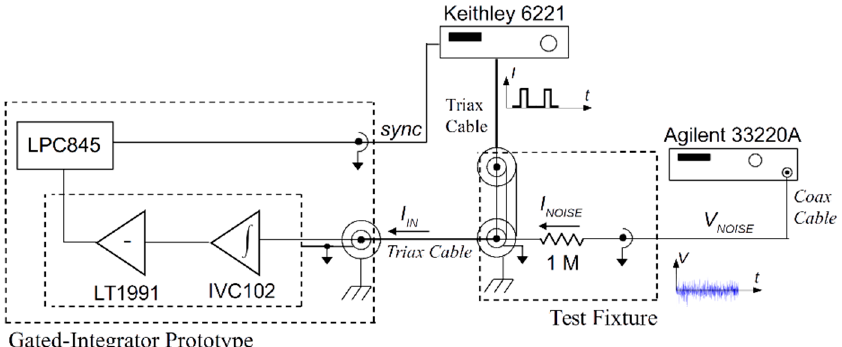
Figure 6. Measurement setup adopted for the circuit prototype characterization. A real device connected at the integrator input has been emulated by a test fixture sourced by a precision AC-DC current generator (Keithley 6221) coupled to an Agilent 33220A waveform generator used to inject a controlled additional white noise current.